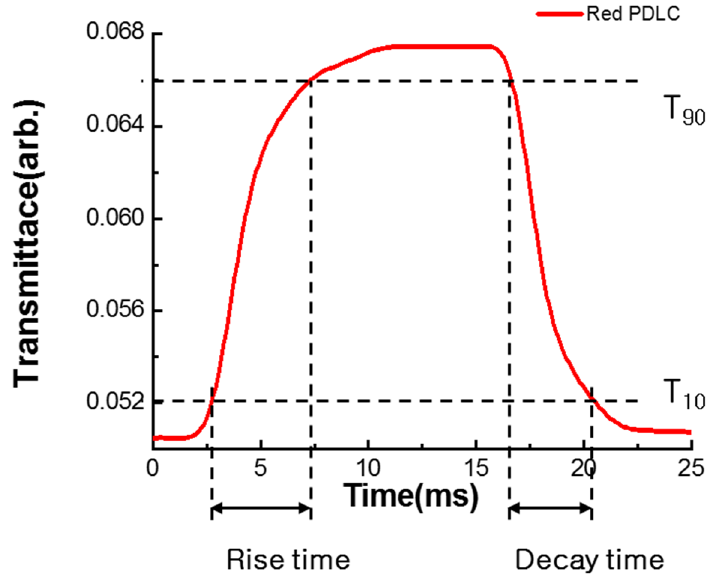
Figure 9. Measured response time of the red PDLCs. The switching time is measured by applying a voltage of 90 V at 1 kHz. The rise time and decay time of the red PDLCs are 4.6 ms and 3.7 ms, respectively. As a total, the switching time of the red PDLCs is 8.3 ms.